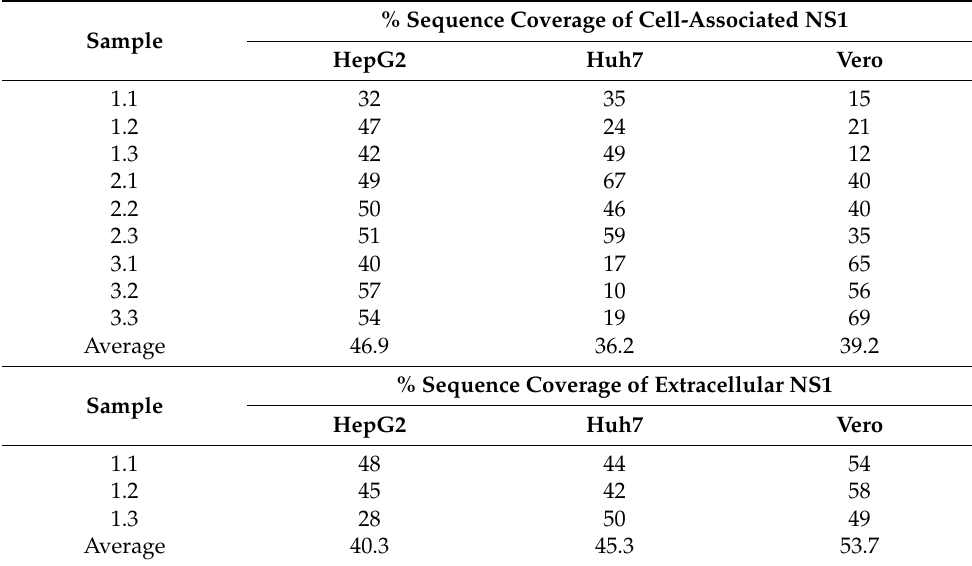
Table 1. Sequence coverage of the DENV NS1 protein as analyzed by LC-MS/MS 1